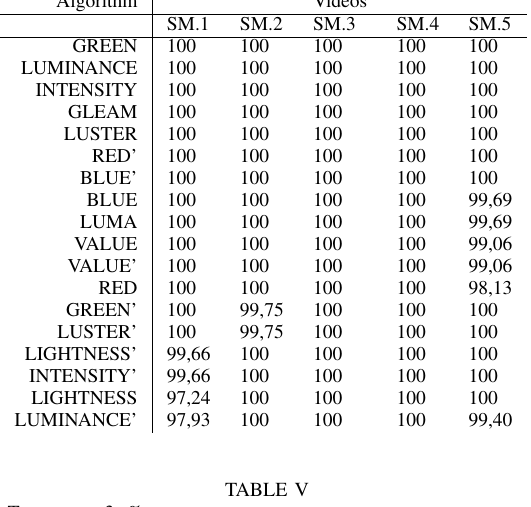
TABLE IV T EMPLATE 2: % OF FRAMES WITH ENOUGH GOOD MATCHING Algorithm